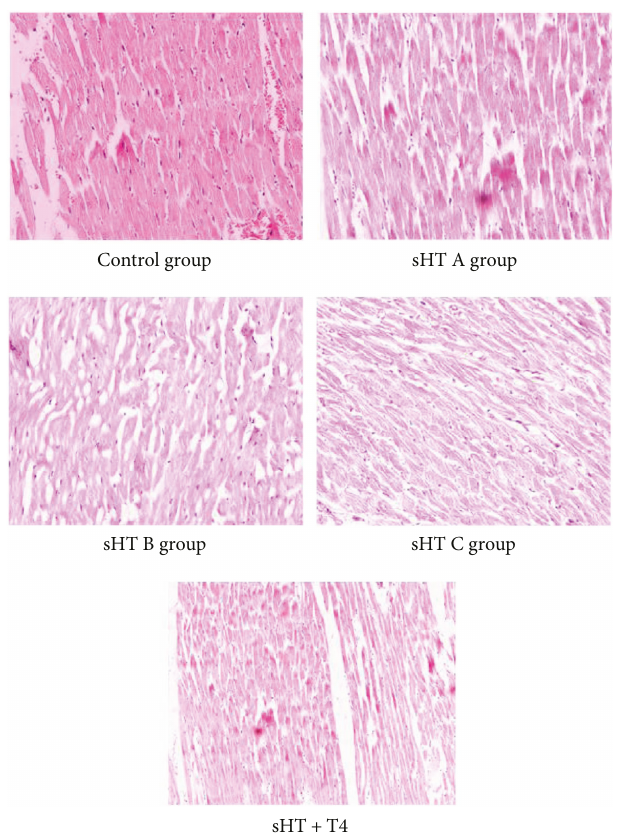
Figure 4: Representative histological sections of the cardiac muscle stained with HE